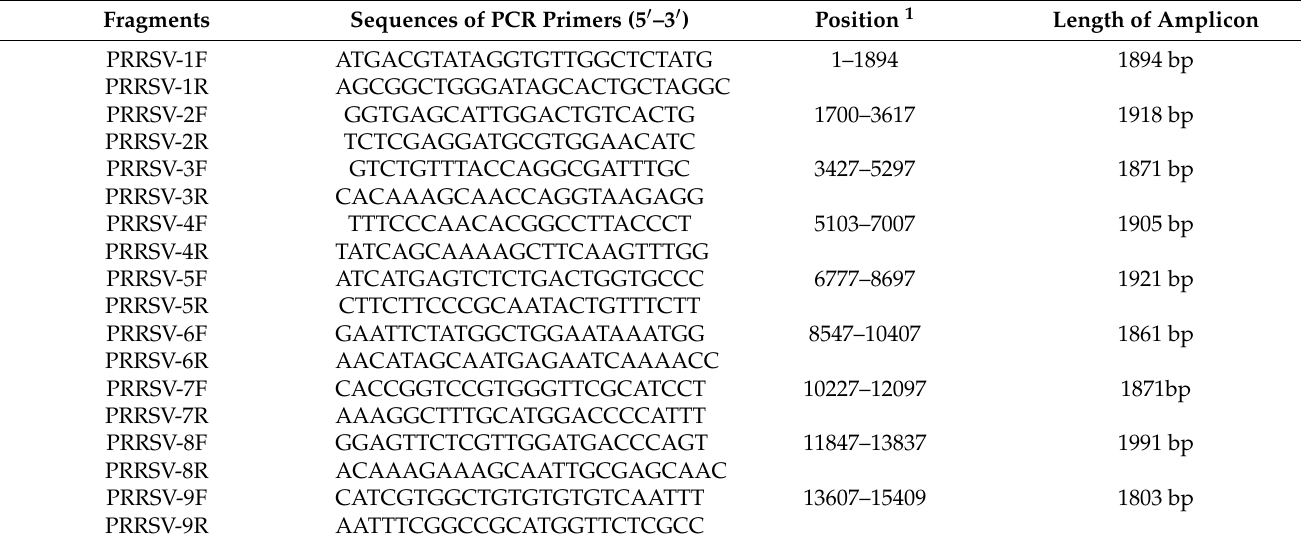
Table 1. Primers used for amplification in the full genome of the PRRSV